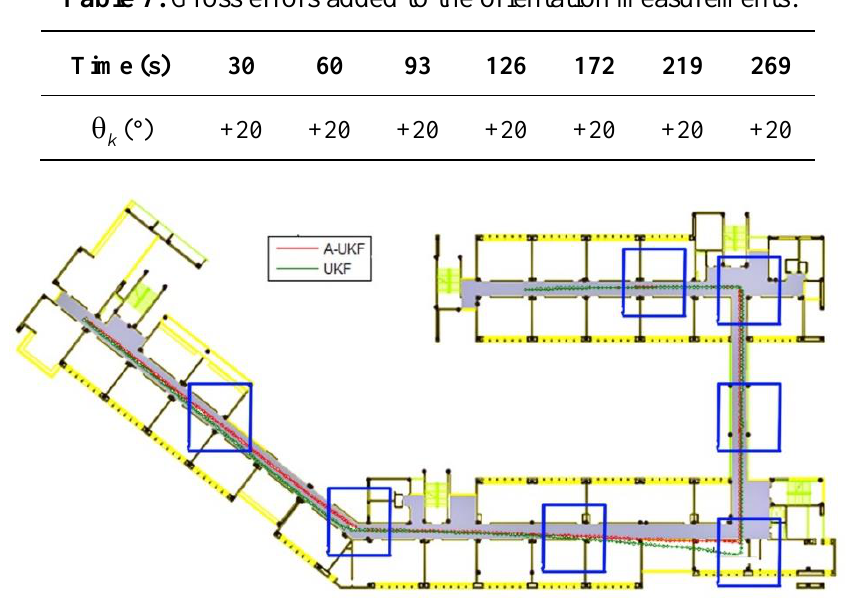
Table 7. Gross errors added to the orientation measurements.